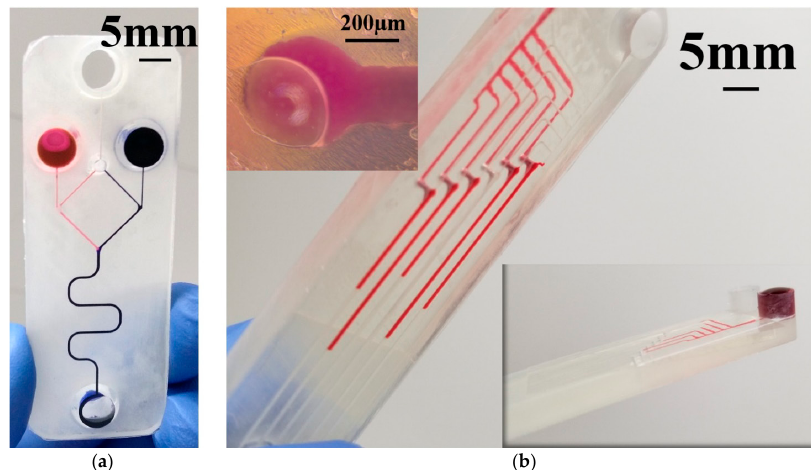
Figure 18. Optical micrographs of the multi-layer microfluidic channels—( a ) Y-channel with violet (gentian violet) and pink (R6G) colors respectively providing an evidence of micro-mixing; ( b ) functioning of a multi-layer printed microfluidic channel (both top and bottom views are depicted). The liquid making a transition from the top to the bottom microfluidic layers through the microfluidic via of 400 μm is also depicted in the inset.